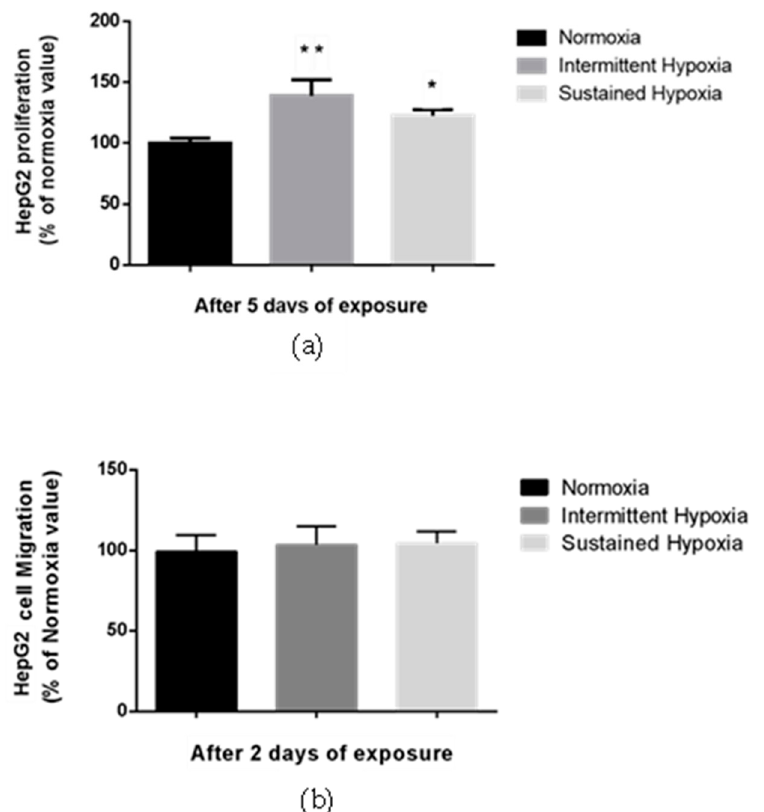
Figure 2. Sustained hypoxia and intermittent hypoxia increase cell proliferation in vitro. ( a ) Proliferation, expressed as a % of normoxia values, of viable HepG2 cells quantified by MTT staining after 5 days of normoxia, intermittent hypoxia or sustained hypoxia exposure; n = 3 independent experiments/group (at least 18 wells/group). * p < 0.05 and ** p < 0.01 on D5 for IH cells compared with normoxia cells, and p < 0.05 for SH cells compared with N cells, Mann–Whitney U test. ( b ) Migration, expressed as a % of normoxia values, of HepG2 cells after 2 days of normoxia, intermittent hypoxia or sustained hypoxia exposure; n = 3 independent experiment/group (6 wells/group: 2 transwells/experiments). Mann–Whitney U test.